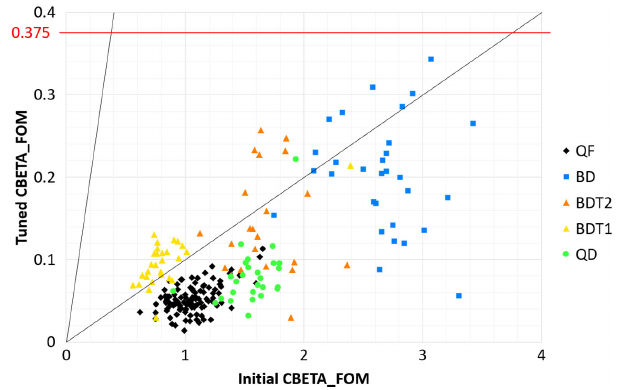
FIG. 11. CBETA FOM of magnet types before and after tuning. Lines for 1 × and 10 × improvement are